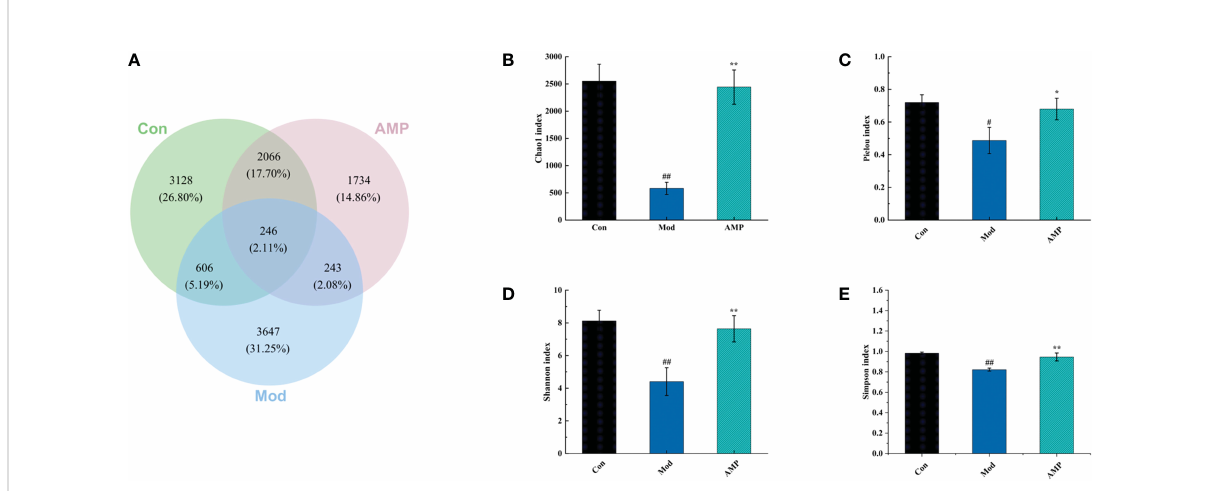
FIGURE 4 Effect of AMP on the number of intestinal OUT and alpha diversity of MGH rats (A) , number of intestinal OUT of rats; (B) , Chao1 index; (C) , Pielou index; (D) , Shannon index; (E) , Simpson index). Compared with Con group, # represents P < 0.05, ## represents P < 0.01; Compared with Mod group, * represents P < 0.05, ** represents P <